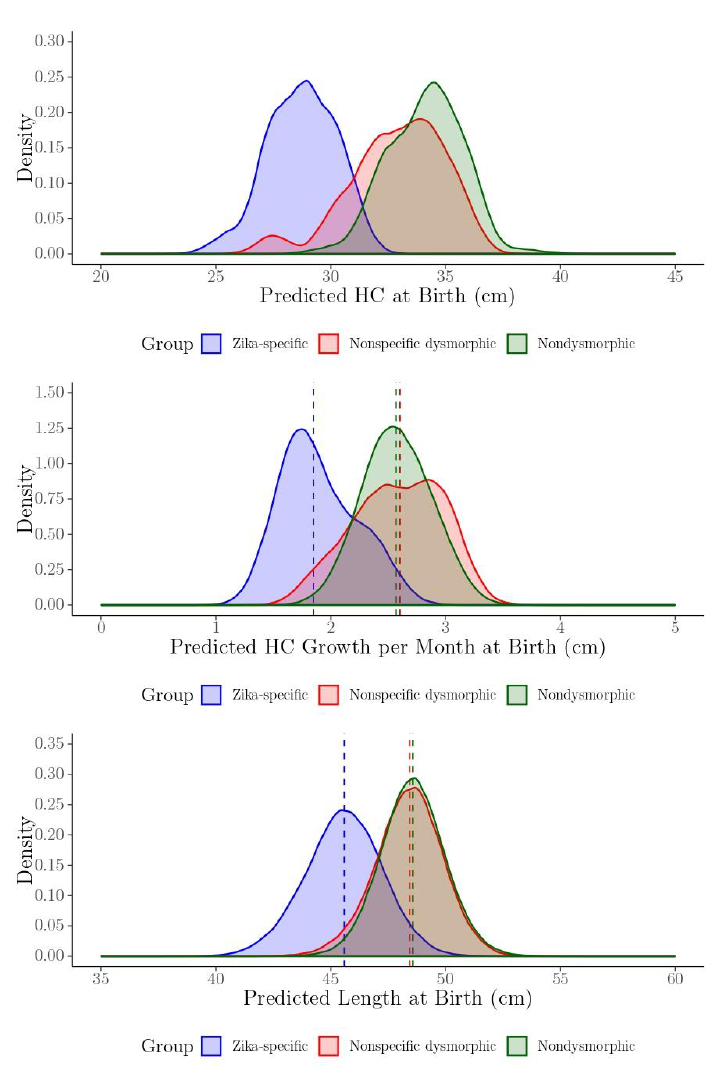
Figure 5. The posterior density plots of the predicted head circumference (HC) and length at birth (cm), and HC instantaneous rate of growth at birth (cm / month) for each child by phenotype group. Modeling results indicate that HC at birth, HC instantaneous rate of growth at birth, and length at birth are predictive of developmental delay (Table 3). The HC at birth and associated rate of growth were the strongest predictors of developmental delay for all ASQ-3 domains. Length at birth and length growth rate were predictive but less consistent than HC across the ASQ-3 domains. We estimated the DQ z -score for each ASQ-3 domain at one, two, and three SD below the mean. For example, under the communication domain, the model estimated that a child with a HC 2 SD below the mean ( – 2SD HC = 27.45 cm, mean = 32.87cm) would have a DQ z -score of approximately − 4. Birth HC had the largest e ff ect on the DQ z -score for each of the five domains, followed by HC instantaneous rate of growth, and birth length, respectively. The estimated e ff ect per one SD decrease from the mean HC were reduced DQ z -scores on the communication ( − 1.30), gross motor ( − 1.57), fine motor ( − 1.67), problem solving ( − 1.29), and personal-social ( − 1.59) ASQ-3 domains. For each one SD decrease from the mean in HC rate of growth, there were reduced DQ z -scores ranging from − 1.27 SD (gross motor) to − 0.86 SD (communication). Length had the smallest e ff ect, ranging from − 0.46 SD (problem solving) to − 0.17 SD (gross motor) per one SD decrease below the